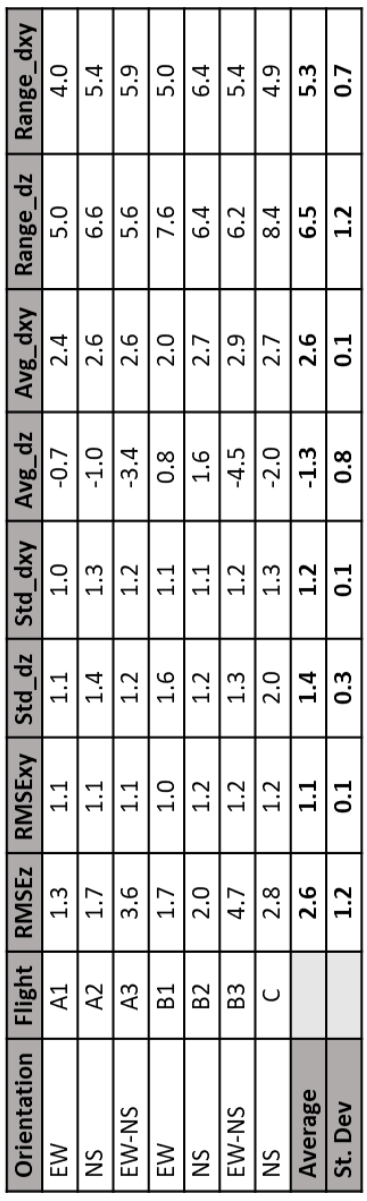
Table 4. Results of DEM analysis at 75 checkpoints